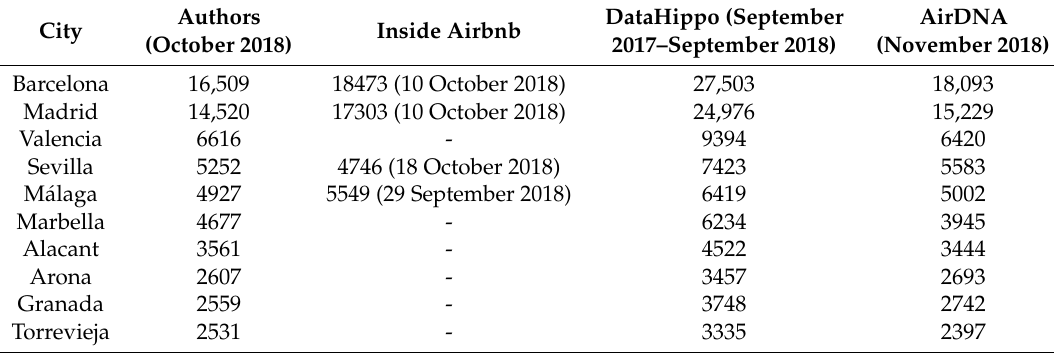
Table A1. Comparison of numbers of Airbnb listings in Spanish cities according to various sources.